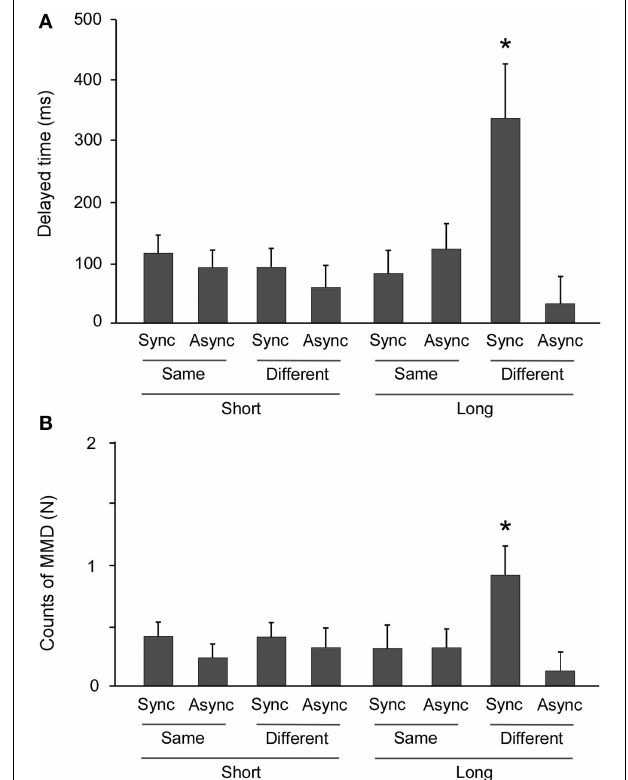
FIGURE 4 | Prolongation of freezing time and incidence of near collision. An ANOVA revealed highly significant Three-Way interaction effects in both delay time (DT) and incidents of moving in a mistaken direction (MMDs). (A) Multiple comparisons tests revealed that DTs were markedly longer in only the combination of synchronization, long distance, and different starting foot conditions ( * : all p < 0 . 05 ). (B) Multiple comparisons tests revealed that the MMD count was higher only when the conditions of synchronization, long distance, and different starting feet were combined, compared to all other conditions ( * : all p < 0 . 05 ). Error bars indicate the standard errors of the